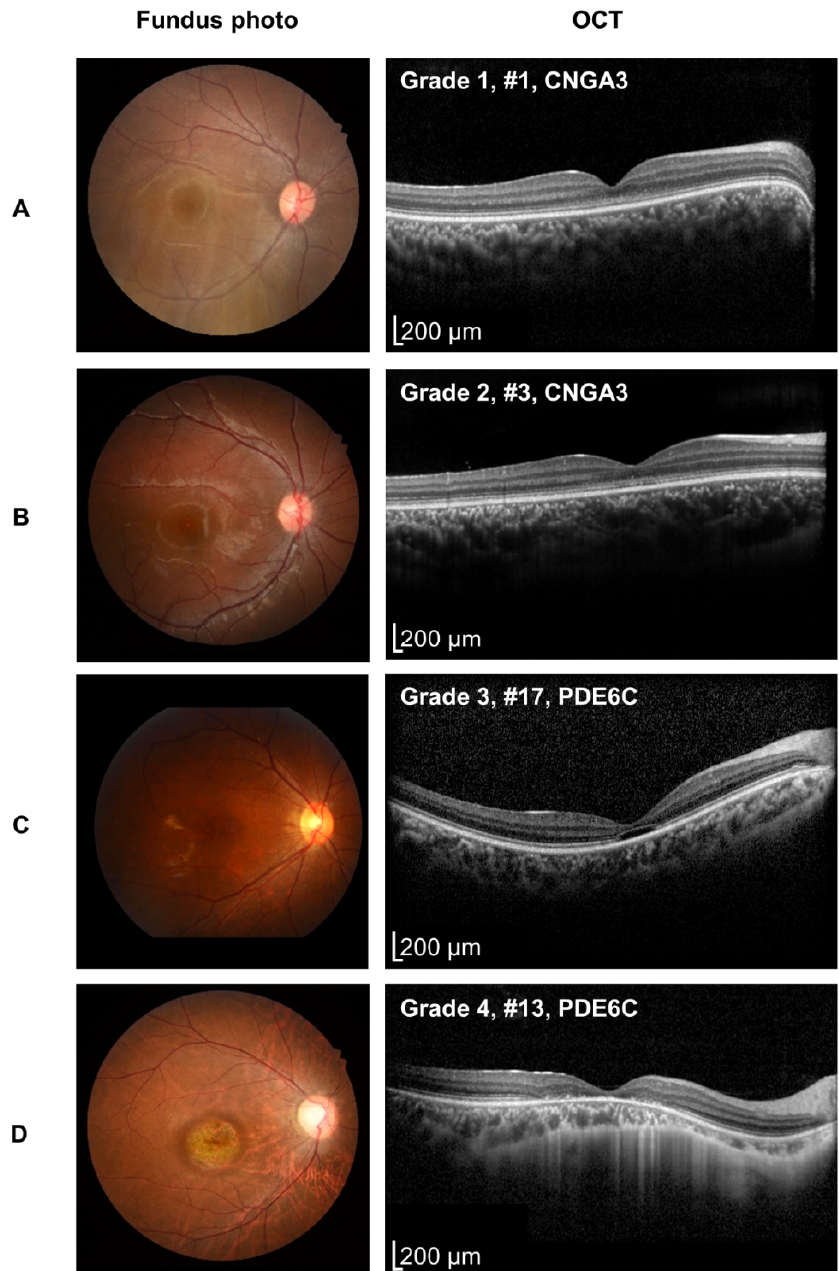
Figure 2. Representative images of multimodal ophthalmic imaging of patients showing various degrees of photoreceptor loss. Fundus photography and optical coherence tomography (OCT) were conducted. In the OCT, the degrees of photoreceptor loss varied into four categories; ( A ) continuous photoreceptor inner segment ellipsoid (ISe), ( B ) disruption of the ISe, ( C ) presence of hyporeflective zone, and ( D ) atrophy of the outer retina and retinal pigment epithelium.